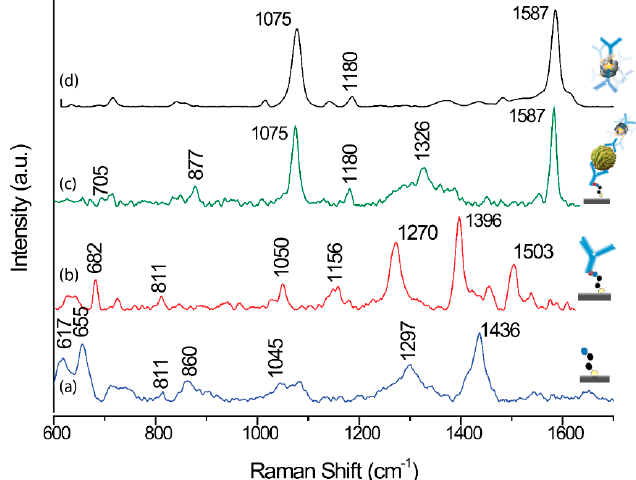
These spectral changes in UV-vis spectroscopy indicate that anti-EpCAM antibodies were